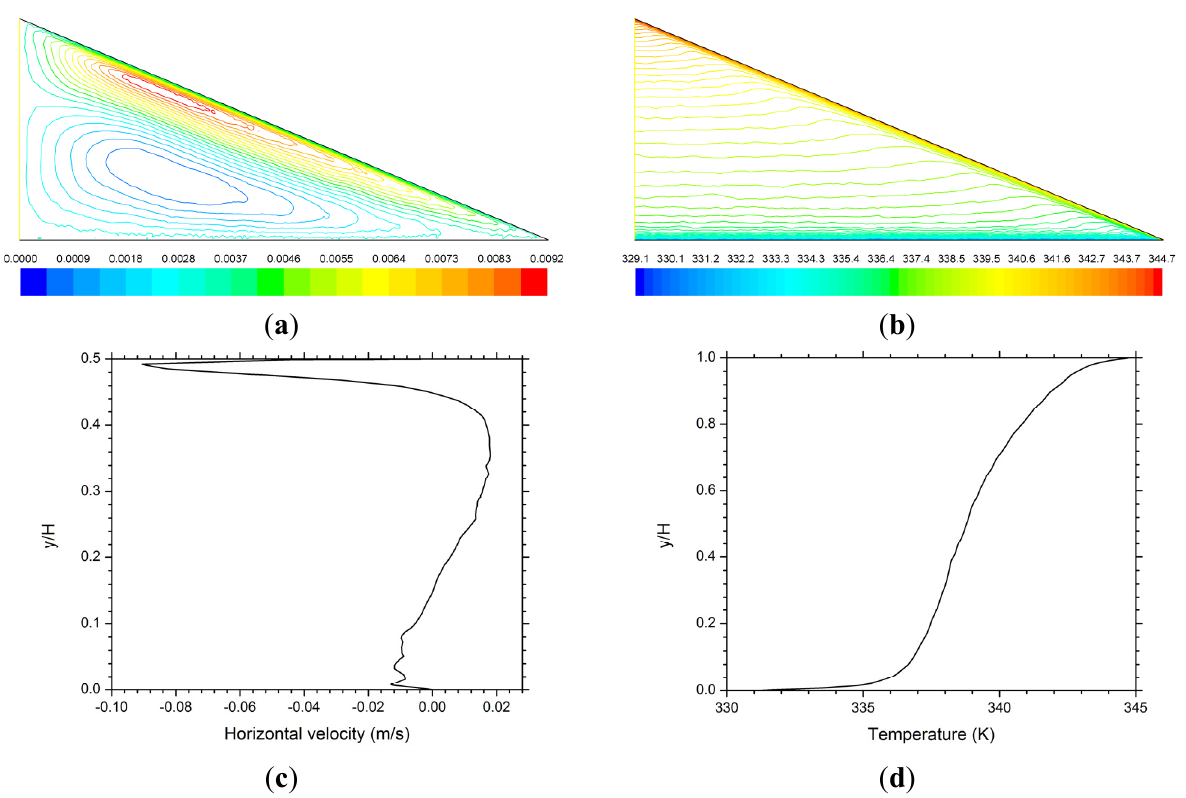
Figure 2. Numerical results for the sealed attic case: ( a ) streamlines (in kg/m s); ( b ) isotherms (in K); ( c ) horizontal velocity profile along the vertical line x = 2 m; and ( d ) temperature profile along the symmetric line x =